Question: Condense the content of this figure into a single sentence.
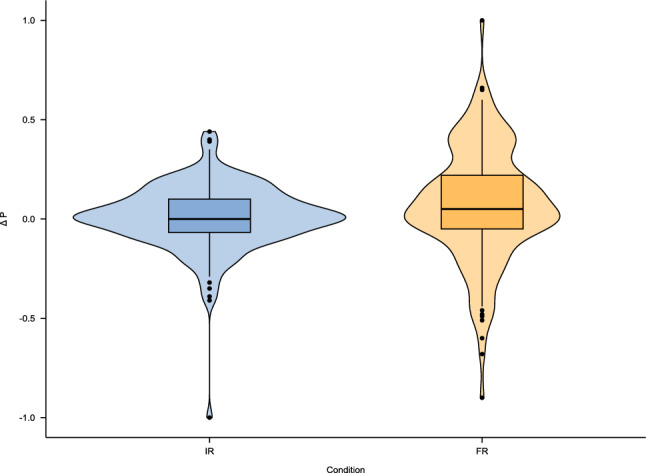
Answer: Distribution of final contingency estimates per condition in Experiment 2. Note. Contingency estimates were calculated for the strength of the association between the most frequent option and the most frequent outcome